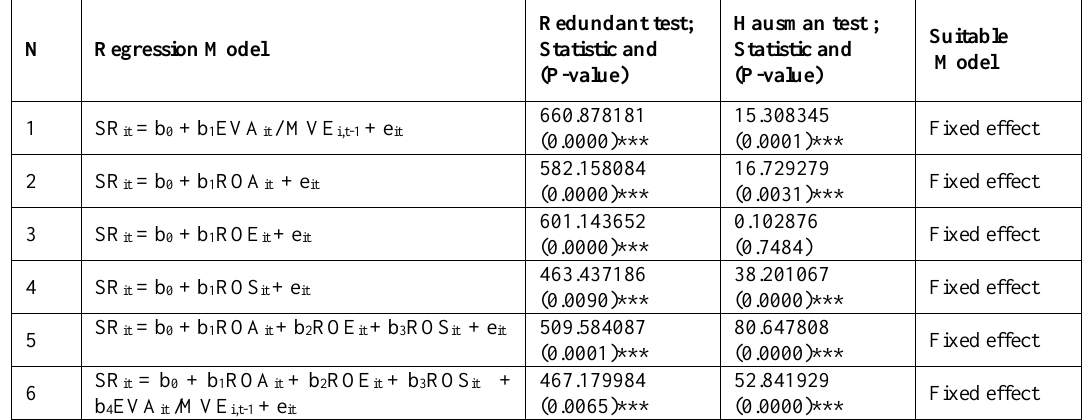
Table 3: Redundant fixed effect-likelihood ratio and Hausman